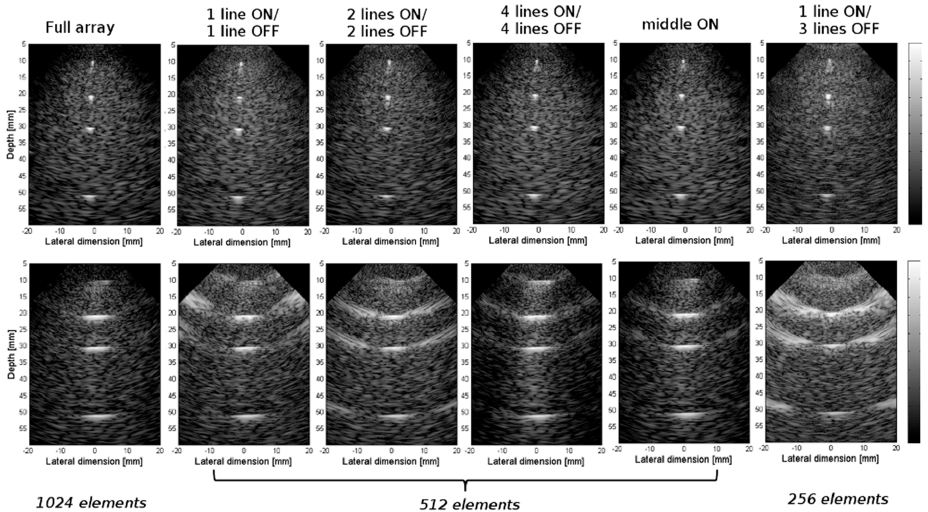
Figure 5. Experimental data acquired with 9 DW on a standard phantom. The ( x , z ) plane (first row) and the ( y , z ) plane (second row) are shown in the center of the US device. Different configurations of the array were used: full array, 1 line ON-1 line OFF, 2 lines ON-2 lines OFF, 4 lines ON-4 lines OFF, middle ON and 1 line ON-3 lines OFF. A dynamic of 50 dB has been used in all the images. At the same time, the ( y , z ) plane illustrates the degradation of the image quality with lower numbers of active elements. The step in the y direction is modified according to the configuration used, this leading to apparition of important artefacts for some cases, in the near and far-field. Not all the lengths of the wires are visible in this plane, due to small misalignment between the US probe and the wires. Table 4. FWHM calculated in the ( x , z ) plane over three scatters located at depths 10, 20, 30 mm and the CR and CNR evaluated on the ( y , z ) central slices of the acquired